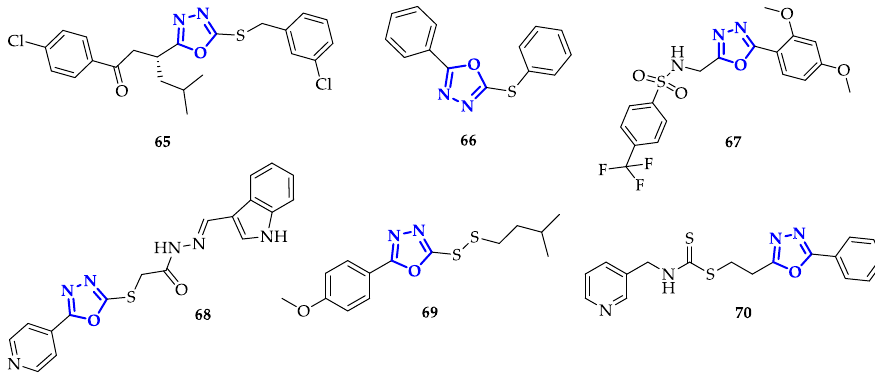
Figure 12. Oxadiazoles containing sulfur-based functional groups.